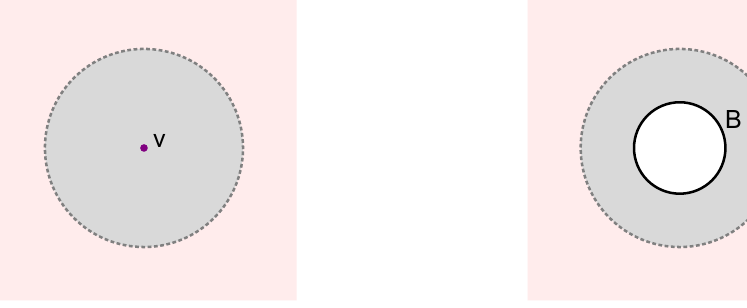
Figure 62 . A relevant deformation inside the disc (gray region) triggering an RG (cid:13)ow to a TQFT. In the left picture, a point-like topological operator v in the TQFT is inserted inside the disc. This construction produces an Ishibashi state on the dotted circle, which is generally not a boundary state. In the right picture, we insert a boundary state B of the TQFT instead, which produces a boundary state of the CFT on the dotted